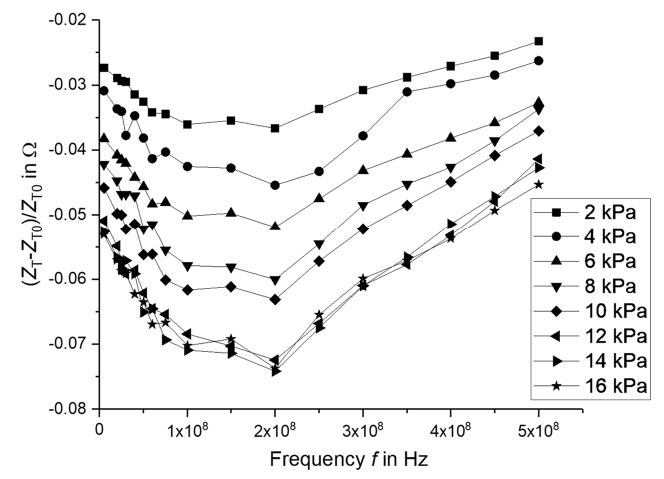
Figure 8. Frequency characteristic of the magnitude of the impedance for different applied pressures to the device under test.